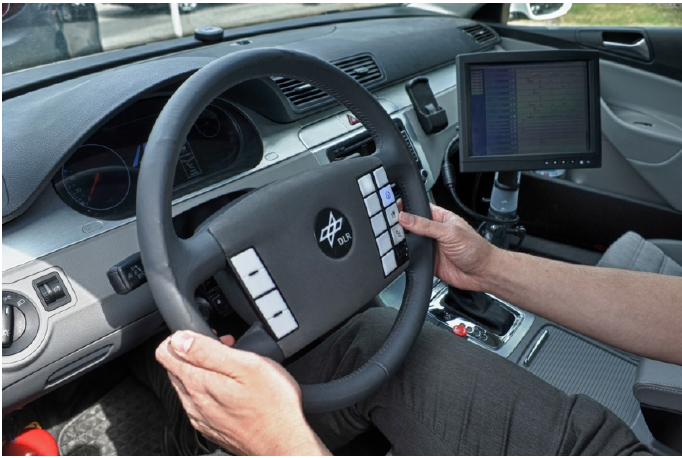
Figure 5: Steering wheel of FASCar ®